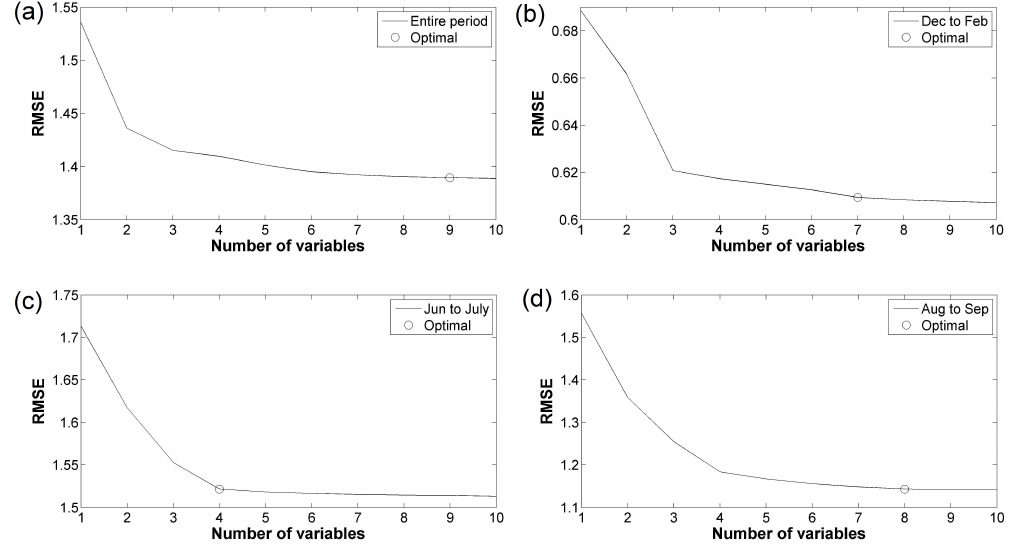
Figure 16. RMSE difference between the MLR calculated eBC and the actual measured eBC at Elandsfontein for the entire measurement period (a) , as well as the December to February (b) , June to July (c) and August to September (d) periods individually.